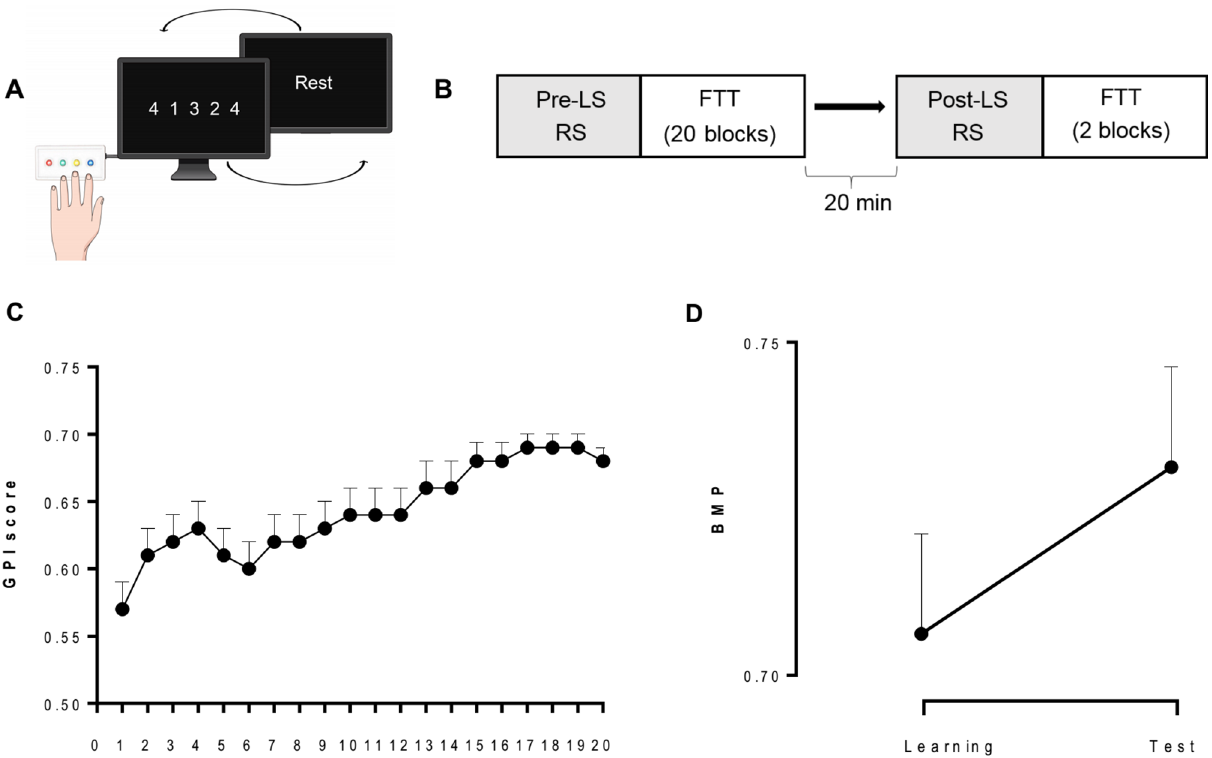
Figure 1. Experimental design and behavioural performance. ( A ) Schematic illustration of the FTT sequence to be reproduced during 30-s experimental blocks designed using Mind The Graph platform, https:// mindt hegra ph. com . ( B ) Experimental procedure : MEG recorded pre-learning session (LS) resting state (RS; 5 min eyes open), immediately followed by 20 FTT training blocks. After a 20-min break, MEG recorded post-learning RS followed by 2 FTT blocks (Test). ( C ) Global Performance Index (GPI) evolution across the 20 FTT blocks during LS. ( D ) Offline changes from the best motor performance (BMP) at learning to the best performance at testing. Error bars are standard errors. Figures ( C ) and ( D ) were created using GraphPad Prism version 9.1.2, GraphPad Software, San Diego, California USA, www. graph pad. com.